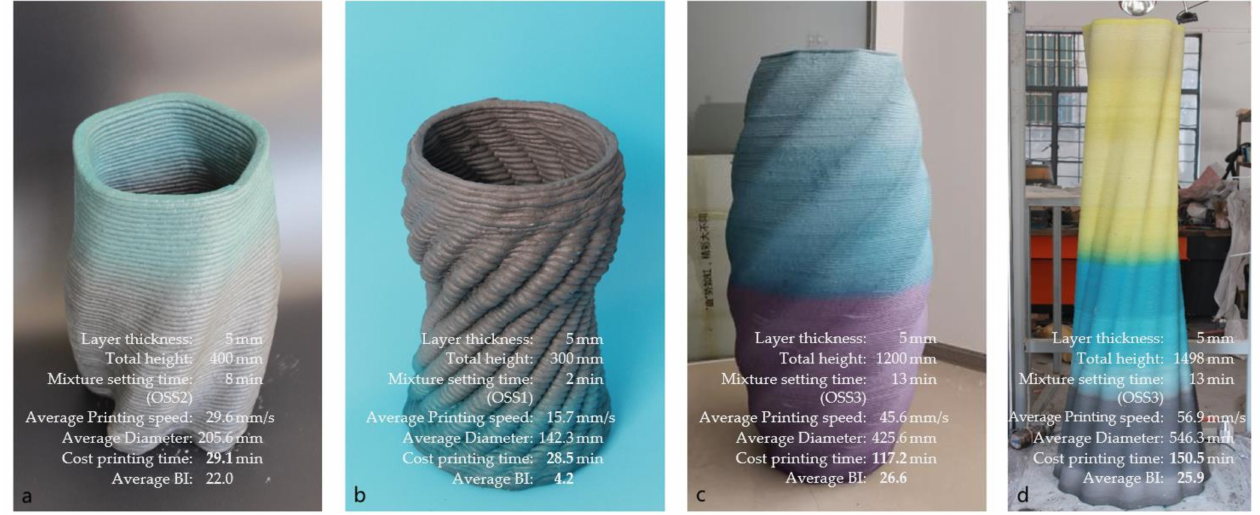
Figure 19. Four decorative printings with same-layer height printing: ( a ) a 40 cm high vase, ( b ) a 30 cm high vase, ( c ) a 120 cm high vase, and ( d ) a decorative hollow sketch with a real height of 1498 mm from a designed height of 1500 mm, requiring 150.5 min and 40 Kg of OSS3